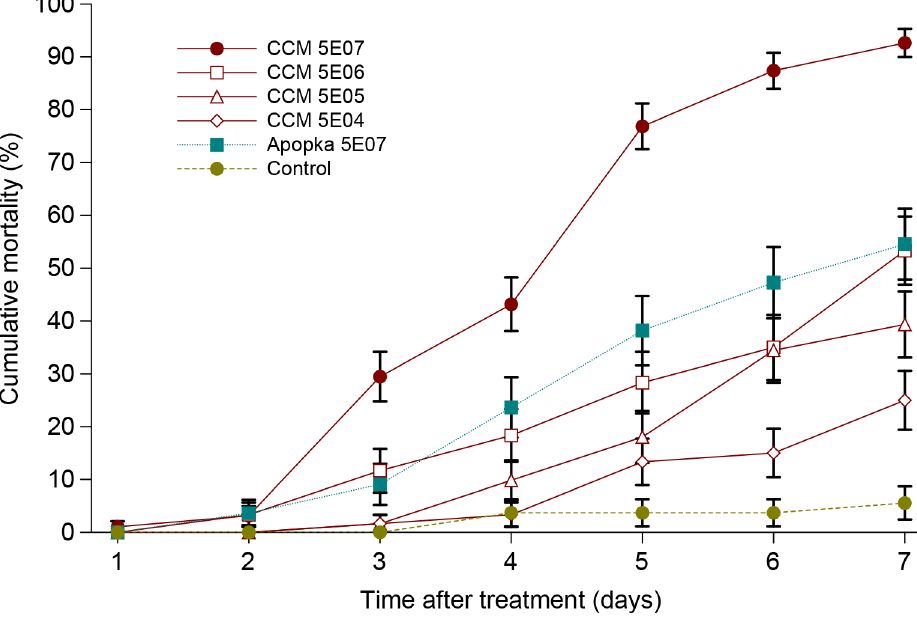
Fig 2. Cumulative mortality of L . decemlineata last-instar larvae treated by CCM 8367 and Apopka 97 strains of I . fumosorosea . Vertical bars indicate standard error.